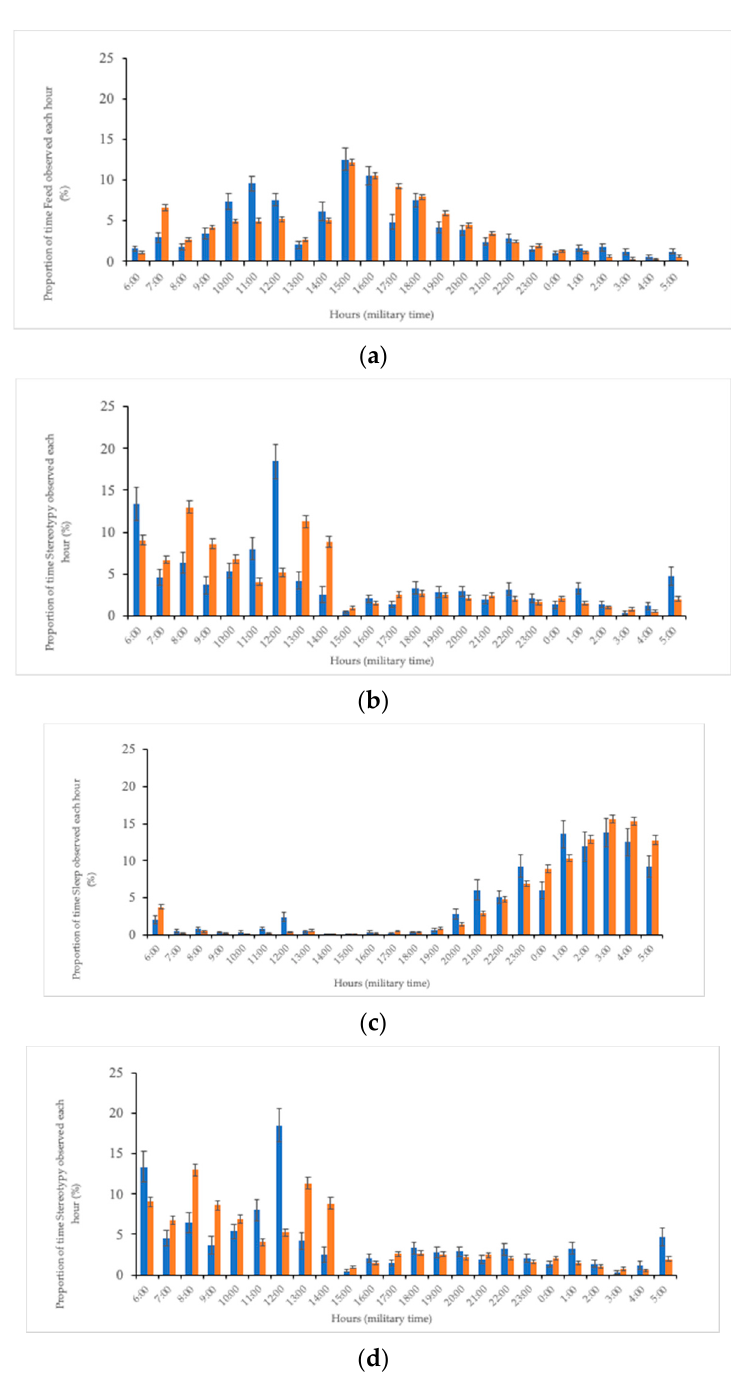
Figure 5. Hourly mean (% ± standard error) proportion of time for 30 min focal (blue) and 24 h interval (orange) data that elephants at the Smithsonian’s National Zoological Park (NZP) were observed performing: ( a ) Feeding behavior, ( b ) Walking behavior, ( c ) Sleeping behavior, and ( d ) Stereotypic behavior.